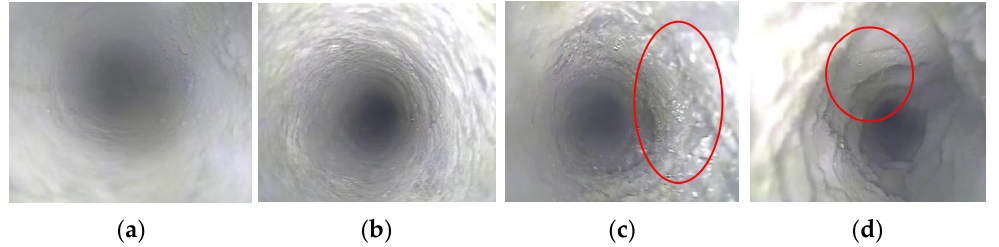
Figure 5. Drilling images of a borehole at different distances from roadway roof. ( a ) 2.5 m. ( b ) 3.0 m. ( c ) 3.5 m. ( d ) 4.0 m.